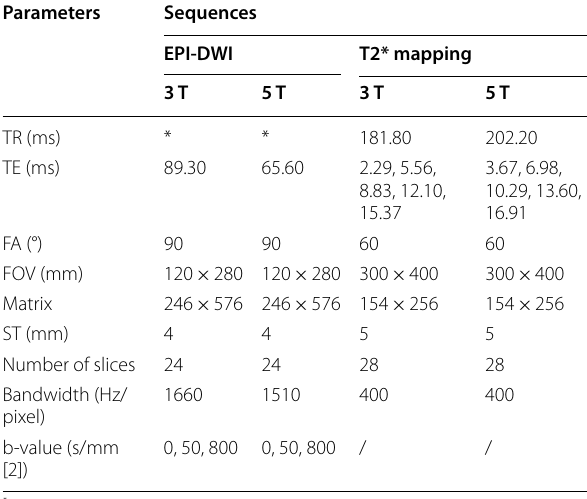
* TR depends on the respiratory interval of participants MRI magnetic resonance imaging; EPI echo-planar imaging; DWI diffusion- weighted imaging; TR repetition time; TE echo time; FA flip angle; FOV field of view; ST slice